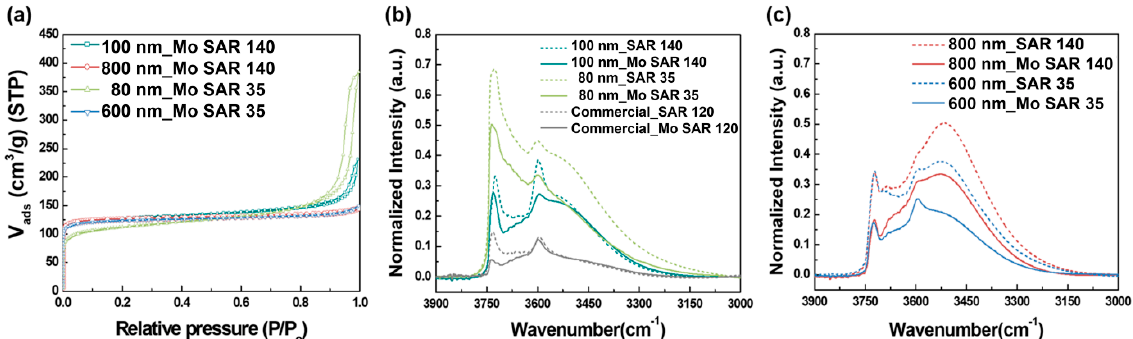
Figure 8. Ar isotherms and IR spectra of Silicalite-1@Al-ZSM-5 zeolite samples after Mo impregnation. ( a ) Ar adsorption- desorption isotherms ( b ) IR spectra of 100 nm_SAR 140, 80 nm_SAR 35, and commercial zeolite (SAR = 120) before and after Mo impregnation. ( c ) IR spectra of 800 nm_SAR 140 and 600 nm_SAR 35 before and after Mo impregnation.